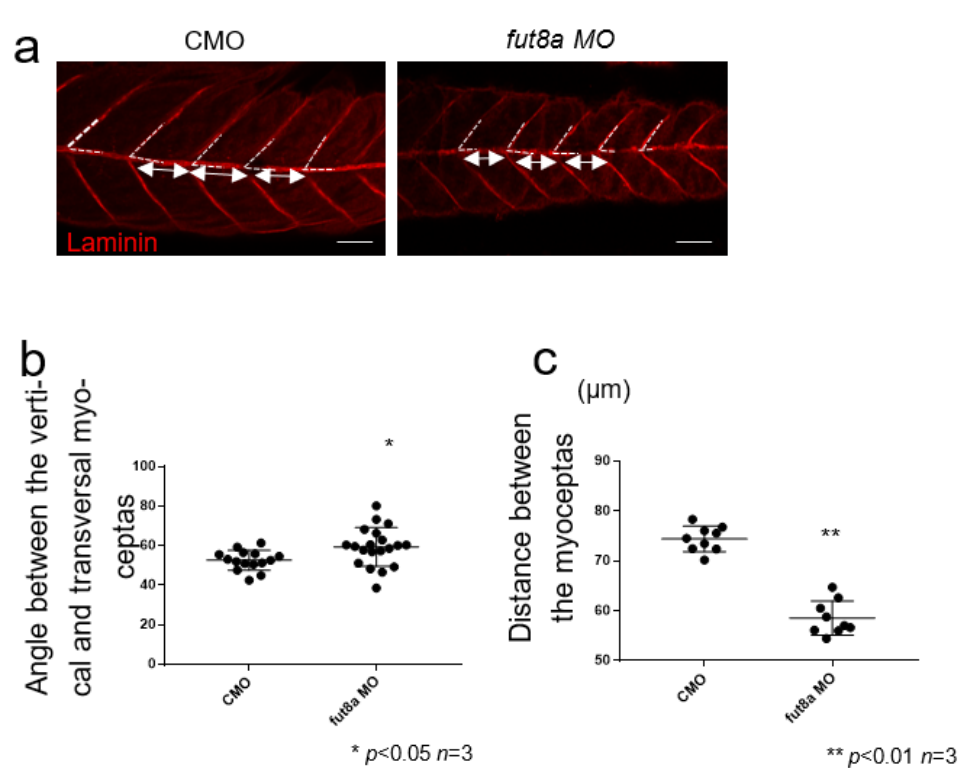
Figure 3. fut8a reduction causes structural abnormalities in myosepta ( a ) Left panel is CMO, right panel is fut8a MO. The white dotted line indicates the angle between the dorsal vertical and transverse myoseptas, and the double arrow indicates the distance of the transverse myoseptas, stained with anti-laminin. Scale bar: 50 μ m. ( b ) Histogram of the angle between the vertical and transverse myoseptas. ( c ) Histogram of the variation in sarcomere length. Five to ten sarcomere lengths were calculated from five fish. CMO: Median 1.956, Max 2.032, Min 1.869. fut8a MO: Median 2.0325, Max 2.153, Min 1.772 ( t -test. p < 0.01, n = 5).